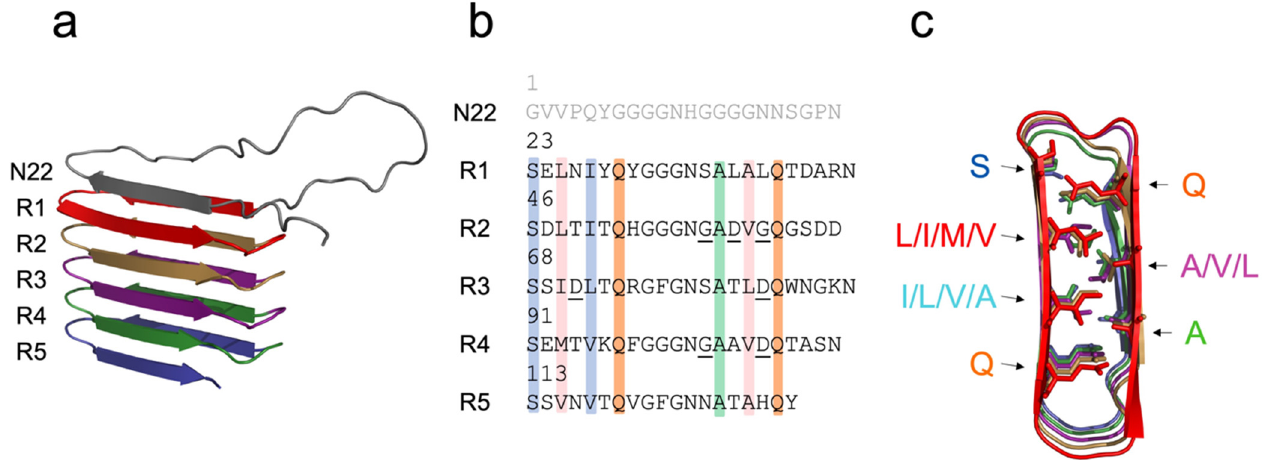
Figure 3. ( a ) CsgA is predicted to form a β -helix (left- or right-handed) where the five imperfect repeats R1–R5 stack on top of each other. Here a right-handed β -helix is shown that was predicted using AlphaFold. ( b ) The primary sequence of CsgA contains an N22 signal sequence, which is important for transport across the outer membrane through CsgG. The five imperfect repeats R1–R5 are found in residues 23–131. The 7 bars illustrate residue ladders formed in the CsgA β -helix due to stacking of conserved residues. Gatekeeper residues (Asp and Gly) are underlined. ( c ) The top-view of the β -helix shown in ( a ). Ladders formed from conserved Ser, Gln, Ala and varied hydrophobic residues are indicated.